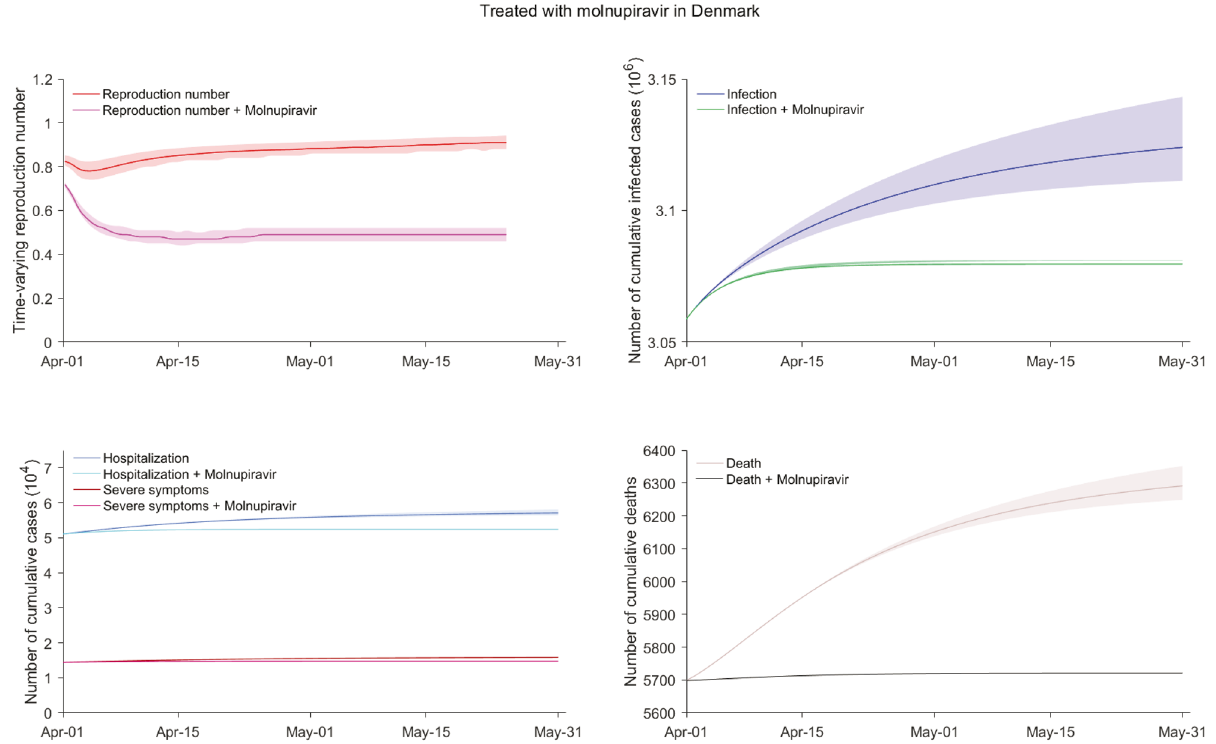
Figure 4. The impact of molnupiravir treatment for all nonhospitalized cases in Denmark. All nonhospitalized cases including latent ones, asymptomatic carriers, and active patients are treated with molnupiravir. The social activity level follows the situations in Week 12, 2022 in the country. The dominating lineages in Denmark (98.8% BA.2 and 1.2%BA.1) are referred from the national integrated surveillance system. The protection against infection of vaccine booster dose is assumed to decrease over time. The protection against reinfection is assumed as 9.3%. The implementation of molnupiravir treatment is assumed since the beginning of the simulation (01 April, 2022). We assumed that the infected cases in our models have not been previously treated with molnupiravir. Cases receiving molnupiravir treatment from day 1 after infection. Molnupiravir treatment was assumed to reduce the transmission rate, and mitigate risk of severe symptoms, hospitalization and death. The shadow parts represent the 95% confidence interval related to